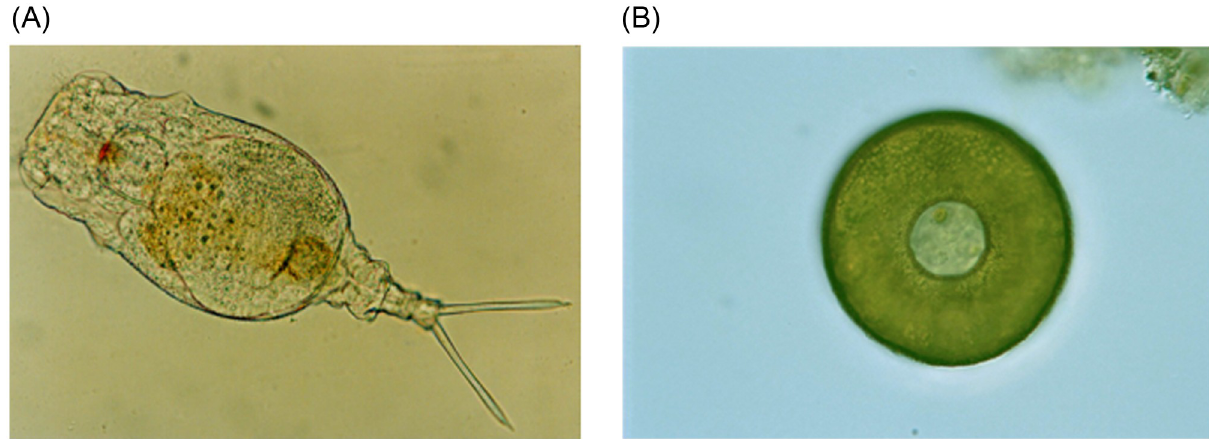
Fig 1. An example of EM